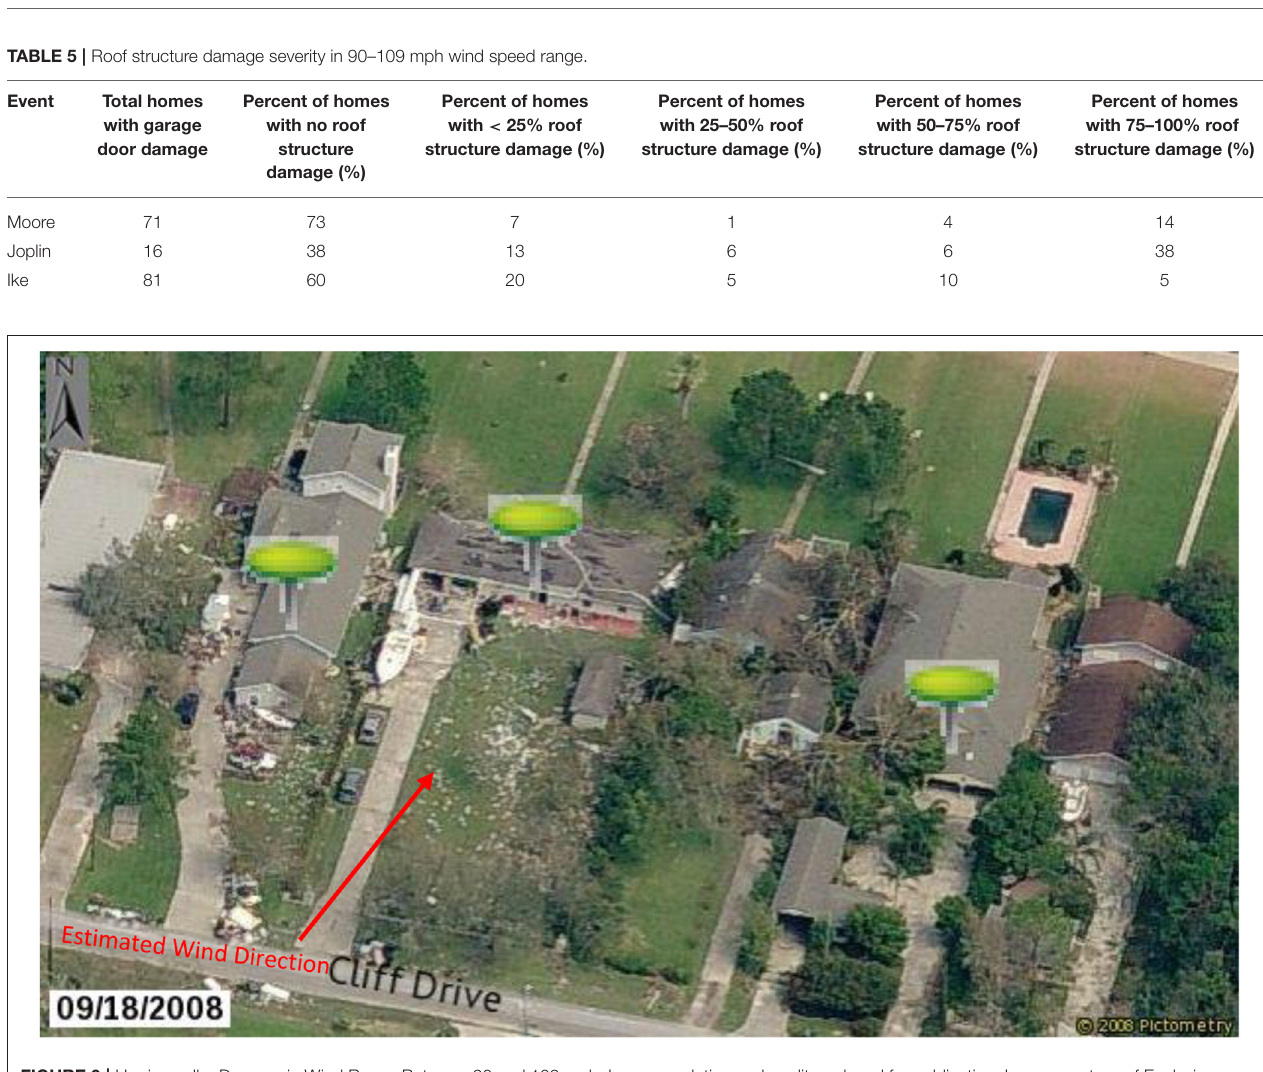
FIGURE 9 | Hurricane Ike Damage in Wind Range Between 90 and 109 mph. Image resolution and quality reduced for publication. Image courtesy of Eagleview Technologies,